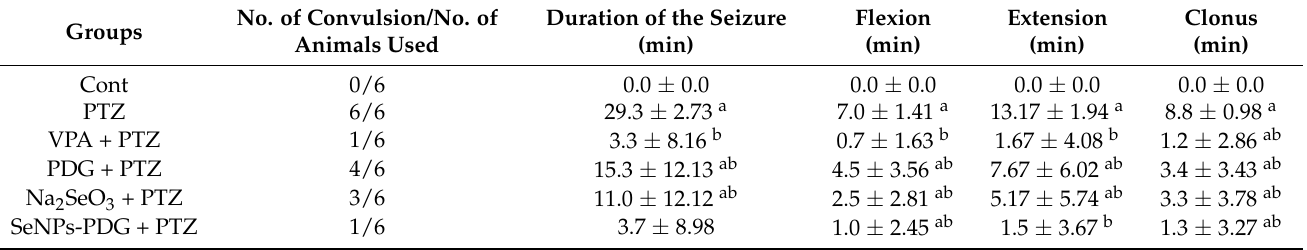
Table 2. Effects of orally administered prodigiosin (PDG), sodium selenite (Na 2 SeO 3 ), and green biosynthesized SeNPs with PDG (SeNPs-PDG) on pentylenetetrazole (PTZ)-induced behavioral changes and seizure latency and